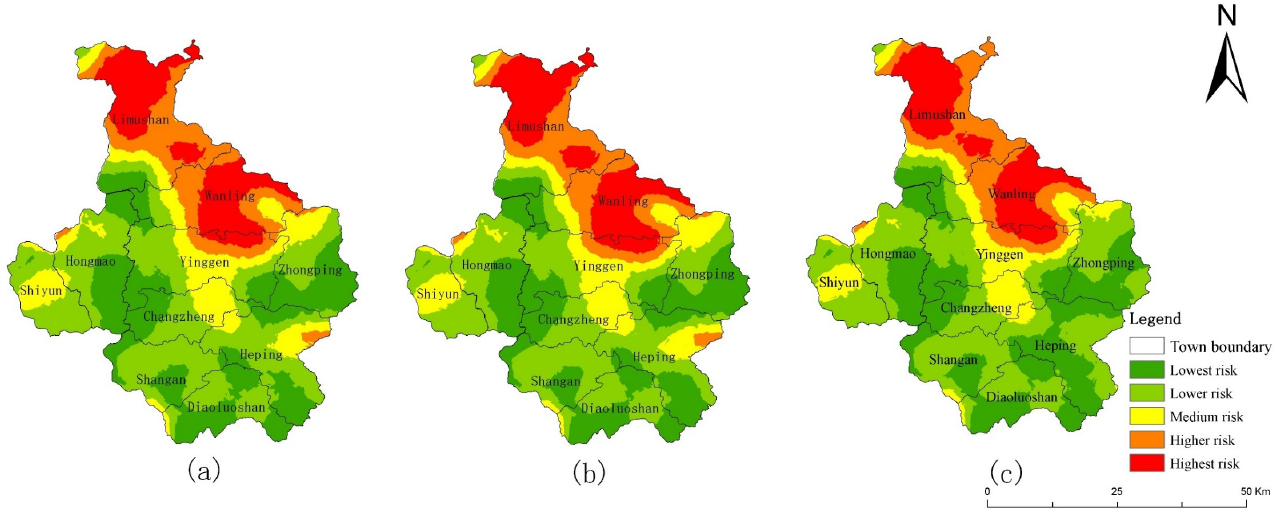
Figure 8. Multi-scenario simulation of landscape ecological risk ( a ) NDS, ( b ) EDS, and ( c ) EPS in 2026 of Qiongzhong County.